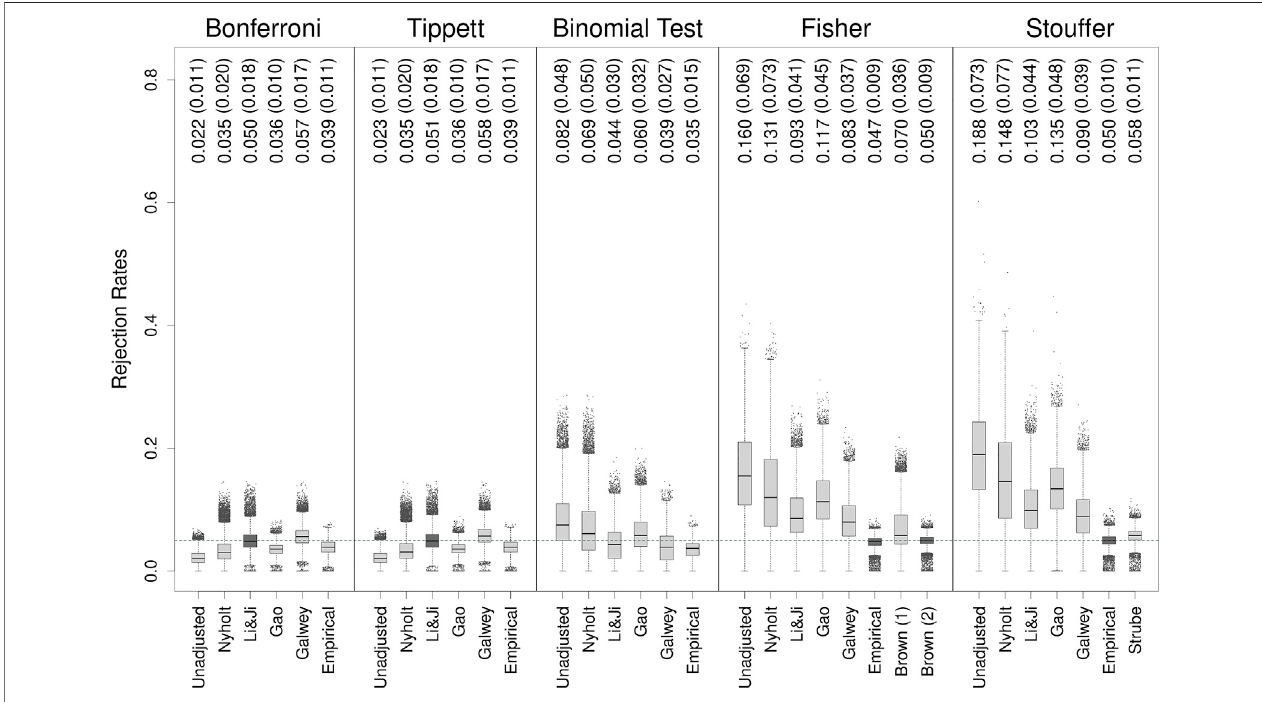
FIGURE1| TypeIerrorratesofmethods for gene-based testing whenapplied totheoriginalHapMap data.Thenumbers abovethe boxplotsshow themean (SD) rejection rates of the methods. The horizontal grey dashed line corresponds to the nominal rejection rate of α = 0.05. Brown (1) and Brown (2) refer to the one- and two- sided versions of Brown ’ s method (i.e., Eqs 13 , 14 , respectively). Individual genes are indicated as points when their rejection rate was more than 1.5 times the interquartile range above the third or below the fi rst